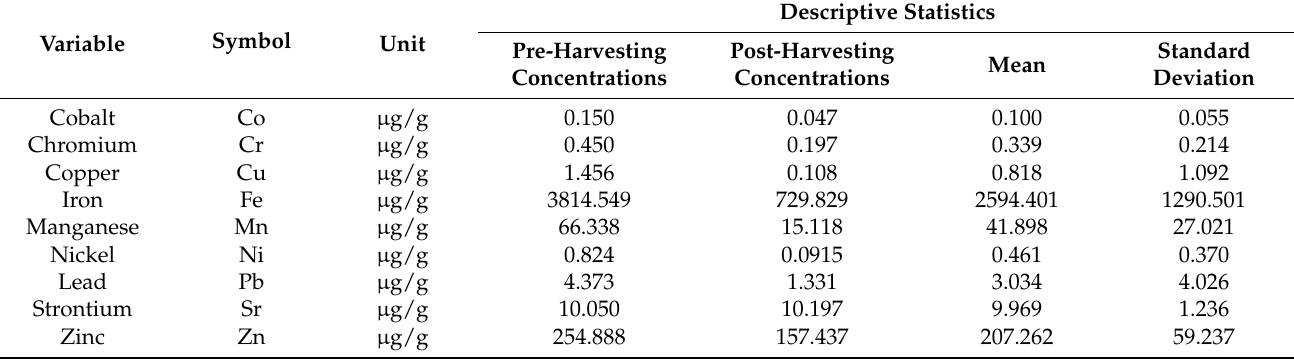
Table 5. Descriptive statistics of heavy metal contents in soil in µ g/g—Pre-harvesting and Post- harvesting stages.